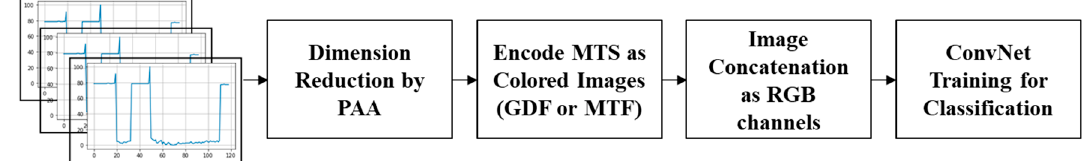
Figure 3. A workflow of the proposed framework for MTS Classification by Convolutional Neural Network (ConvNet).